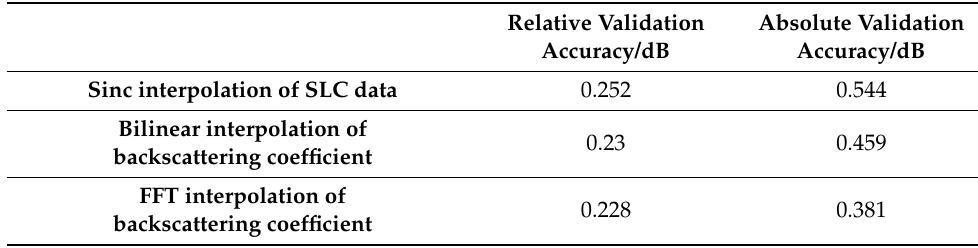
Table 4. Validation accuracy of different interpolation